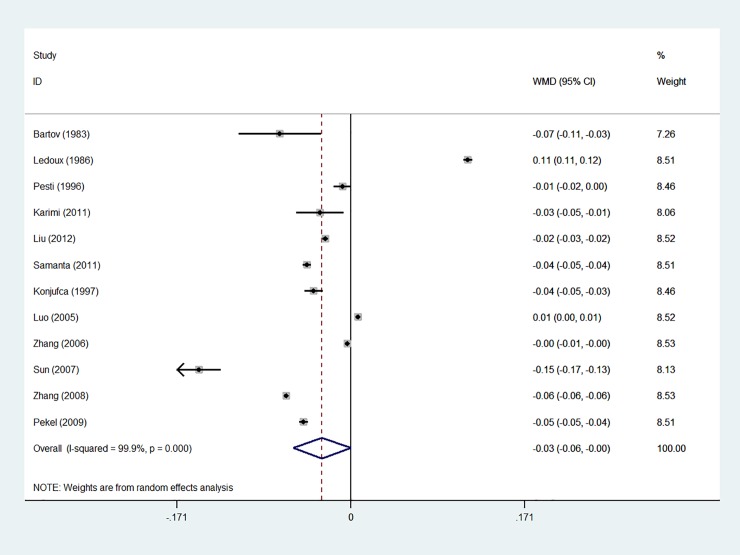
Forest plot of FCR.